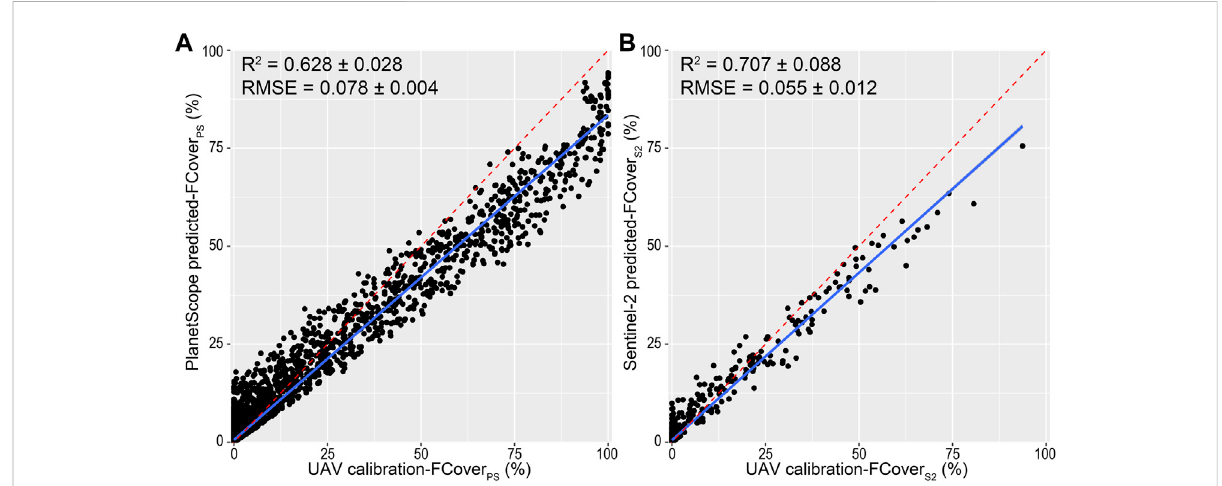
FIGURE 3 Relationship between calibration A. saligna fractional cover (e.g., UAV calibration-FCover) and predicted fractional cover obtained by (A) PlanetScope (predicted-FCoverPS) and (B) Sentinel-2 (predicted-FCoverS2) classi fi cation models. Blue depicts the linear regression between predicted FCover and calibration FCover. Red dashed lines depict ideal regressions of perfect match among predicted-FCover and calibration- FCover values. RF predictive performance ( R 2 ) and root mean square error (RMSE) for each regression are also